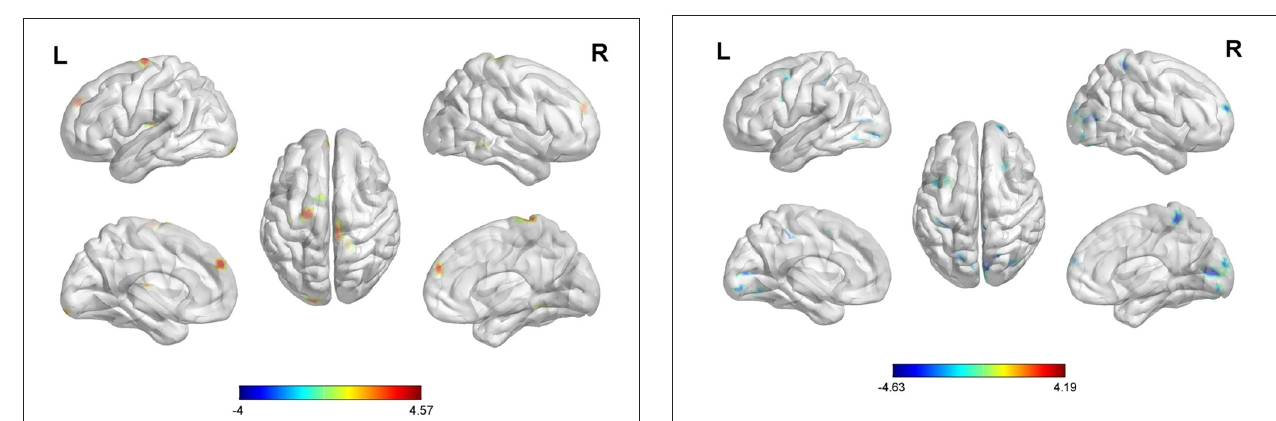
FIGURE 3 | Differences in left middle occipital gyrus (MOG.L) based FC between early postmenopausal women and controls (the peak level threshold was set at p = 0.001; cluster level FDR-corrected p < 0.05 or Small-volume corrected, FWE-corrected at p < 0.05 with a cluster size threshold of 20 contiguous voxels). All the FC strengths were decreased and marked in